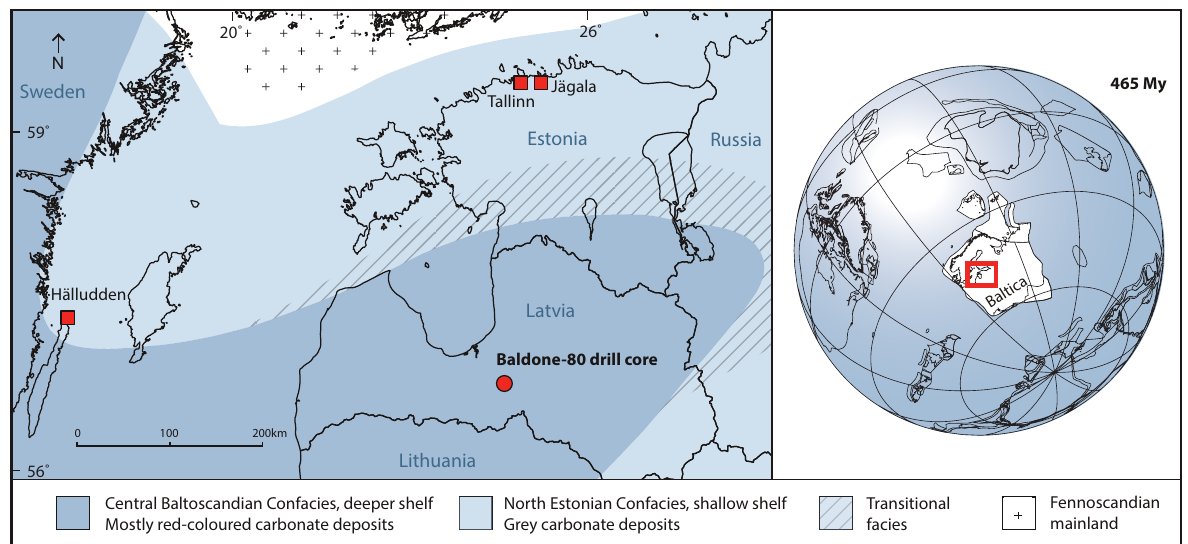
Fig. 1. Locality map and palaeogeography of the study area during early Darriwilian Kunda time. The configuration of the Baltoscandian palaeobasin is according to Männil